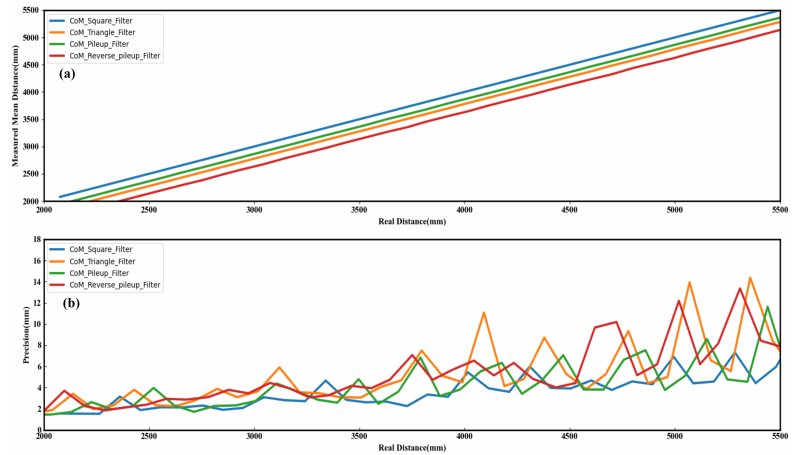
Figure 7. The results of 200 measurements with different profile-matched filters: ( a ) Mean distance. ( b ) Standard